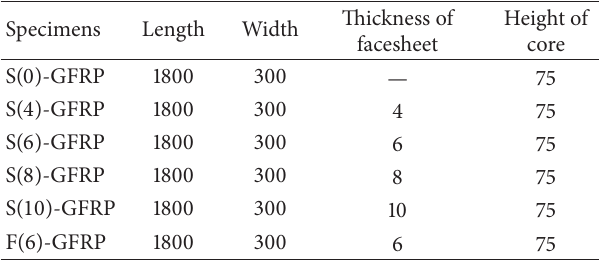
Table 2: Size of specimens (unit: